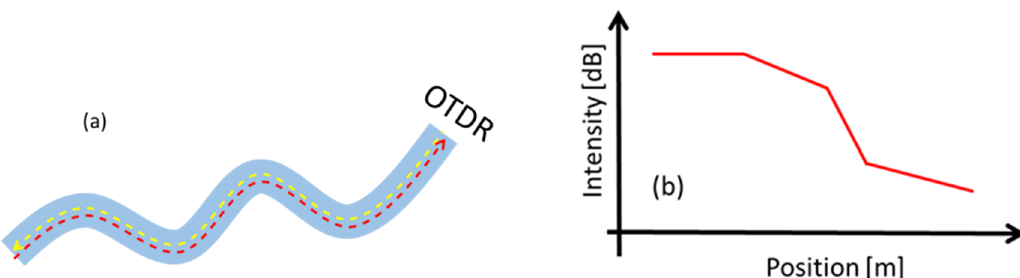
Figure 5. ( a ) Optical time domain reflectometry (OTDR) and fiber basic working configuration, the yellow dashed line stands for the pulsed excitation laser injected in the fiber, while the red dashed arrow represents the signal (Rayleigh, Raman, Brillouin) back-scattered by di ff erent points of the fiber. Each excitation is followed by back-scattered signals that reach the OTDR with di ff erent temporal delays related to the distance from the OTDR allowing the spatially distributed monitoring; ( b ) Typical OTDR trace recorded in a fiber that features di ff erent radiation-induced attenuation (RIA), such as for example as a consequence of a di ff erence in the absorbed dose. The Lambert–Beer law allows evaluating the RIA, and in P-doped fiber, the dose [118].